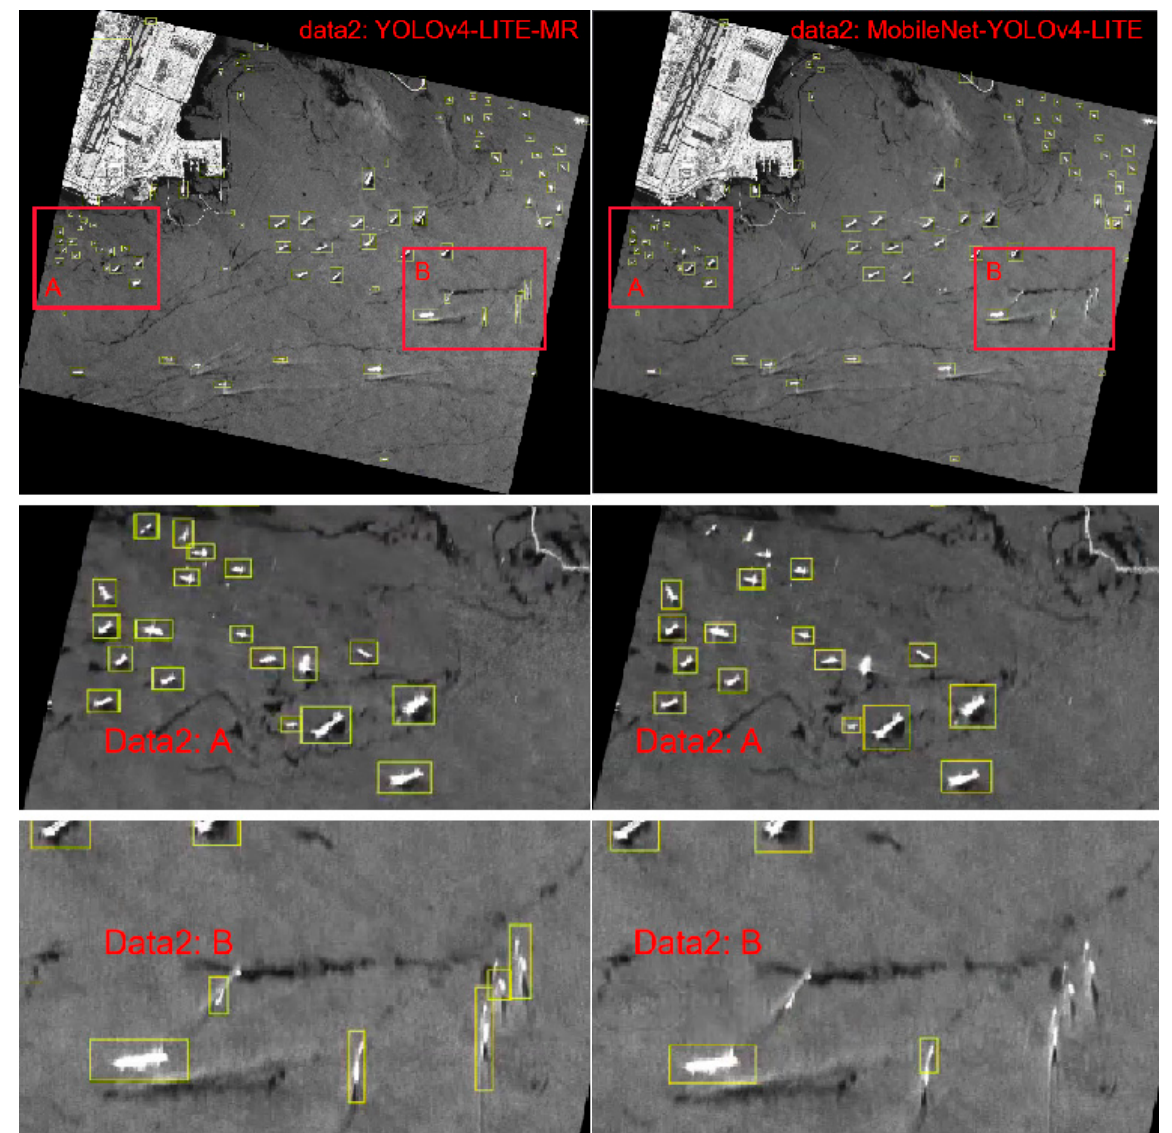
Figure 13. Comparison of the detection results of YOLOv4-LITE-MR (left column) and MobileNet- YOLOv4-LITE (right column) in data2. A and B are sub-images in data2.